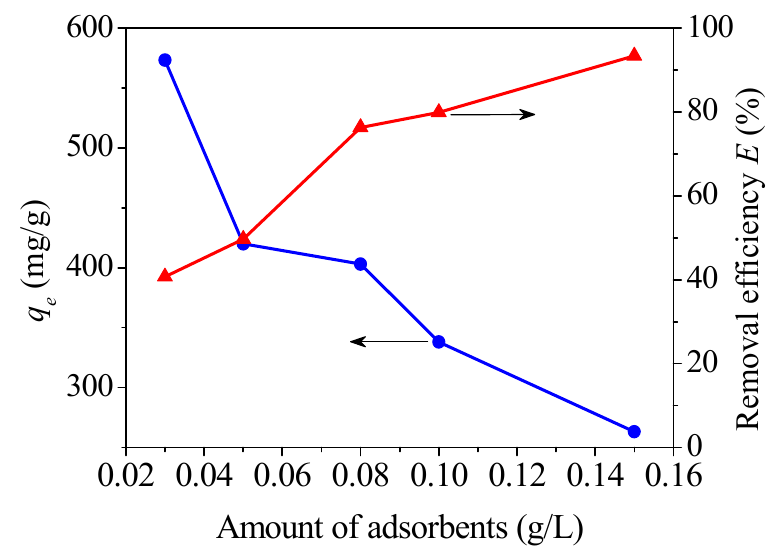
Figure 11. Effect of dosage with CoFe 2 O 4 @SiO 2 -Ppy as adsorbent.